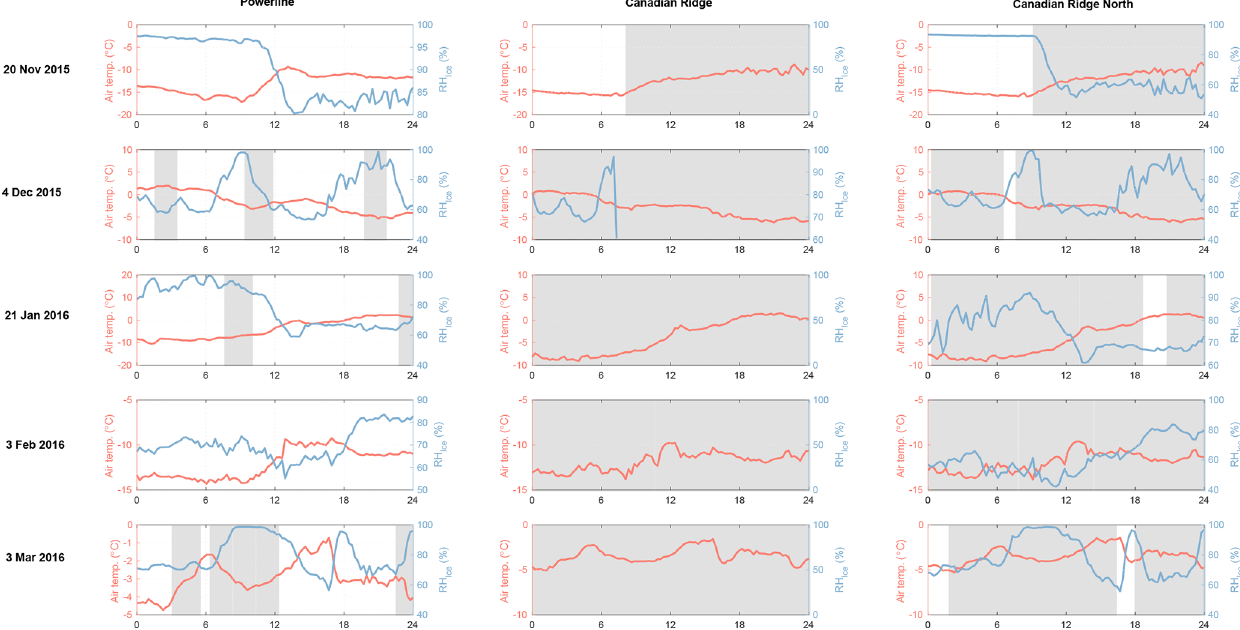
Figure 2. Temperature and relative humidity 15min average measurements at approximately 2m above the snow surface during the five nights of investigation at three nearby micrometeorological stations. Flagged data have been removed from the time series and presented as gaps. Shaded gray areas are times when concurrent average wind speeds were above 3ms − 1 . Note the correlation between sites for both variables and the varying y axes between